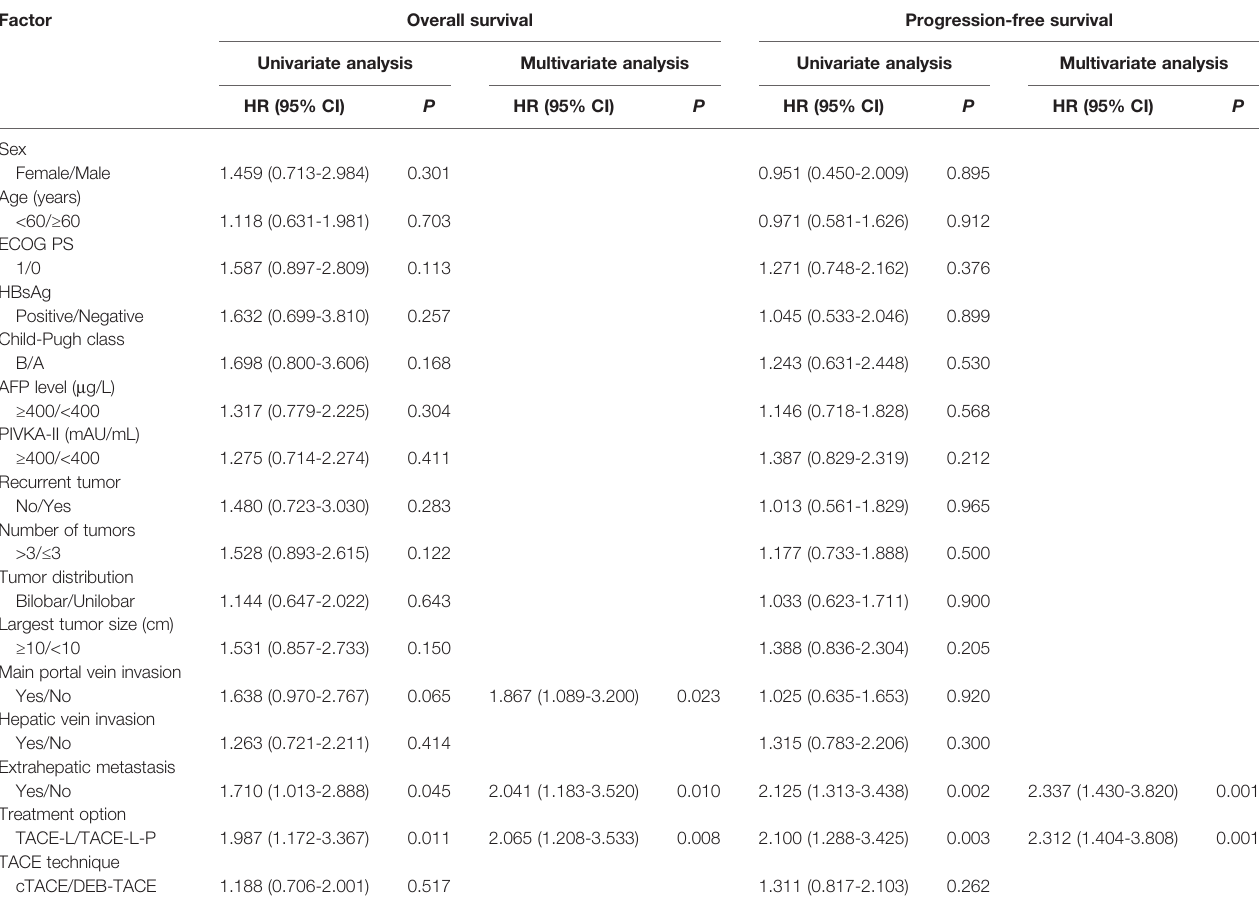
TABLE 2 | Analyses of prognostic factors for